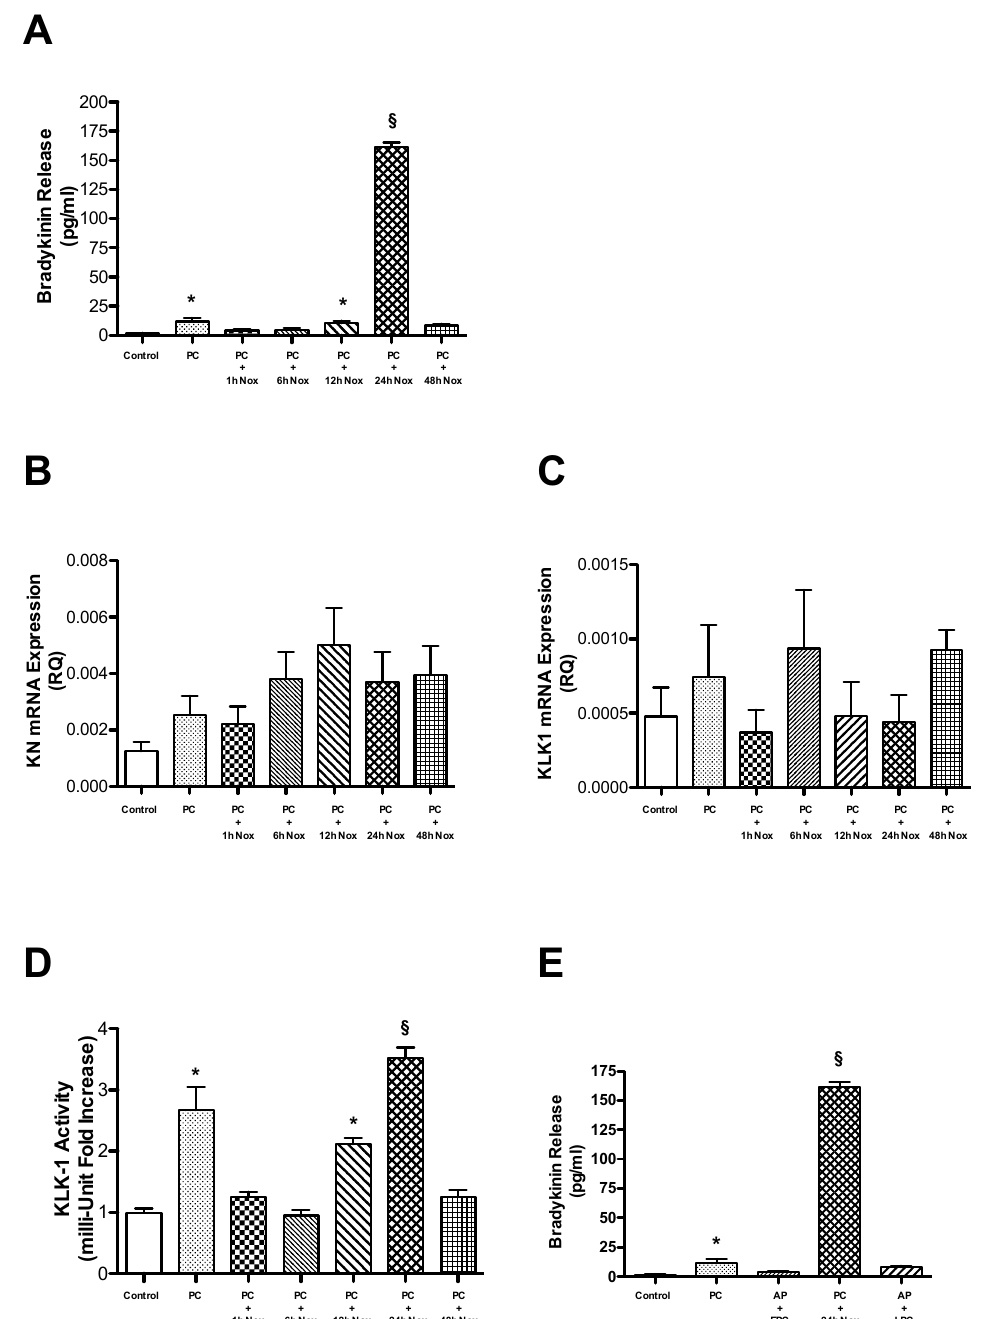
Figure 1. Cells were subjected to preconditioning (PC). ( A ) Bradykinin (Bk) production was assessed at di ff erent times following PC (Nox: normoxia). The bar graph shows the concentration (mean ± SEM) of Bk, representative of four independent experiments. The transcription of the mRNAs coding for ( B ) kininogen (Kn) and ( C ) tissue kallikrein (KLK1) was assessed at di ff erent times following PC. The bar graph represents the mean ± SEM, expressed as the RQ value, of four independent experiments. ( D ) KLK1 activity was assessed at di ff erent times following PC. The bar graph shows the mean ± SEM, expressed as the fold increase in KLK1 activity over that in control cells, of five independent experiments. ( E ) Bk synthesis was measured in early and late preconditioned cells, in the presence and absence of a KLK1 selective inhibitor, aprotinin (AP). The bar graph shows the concentration (mean ± SEM) of Bk, representative of three independent experiments. Nox: normoxia. * p < 0.001 vs. control; § p < 0.001 vs. control and PC, by one-way ANOVA with a post hoc test of